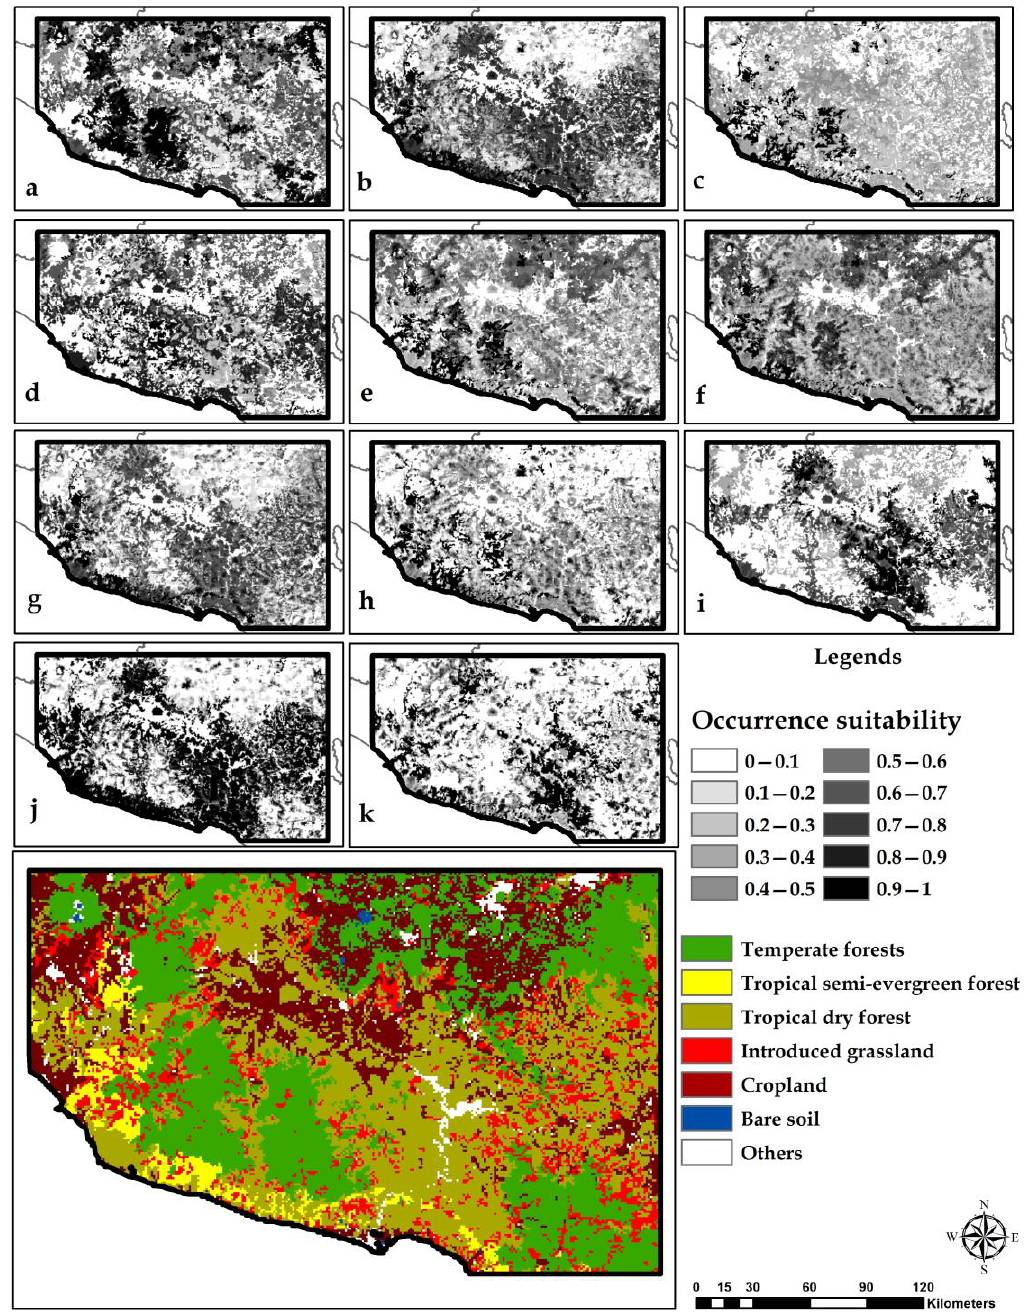
Figure A2. Generalized linear models (GLM) for 11 carnivore species and vegetation types in western Michoacán. ( a ) Bassariscus astutus , ( b ) Nasua narica , ( c ) Procyon lotor , ( d ) Conepatus leuconotus , ( e ) Canis latrans , ( f ) Urocyon cinereoargenteus , ( g ) Leopardus pardalis , ( h ) Leopardus wiedii , ( i ) Herpailurus yagouaroundi , ( j ) Puma concolor and ( k ) Panthera onca . A land-cover map is included to visualize its spatial configuration, along with the different habitat association models for each species, for the whole study area.